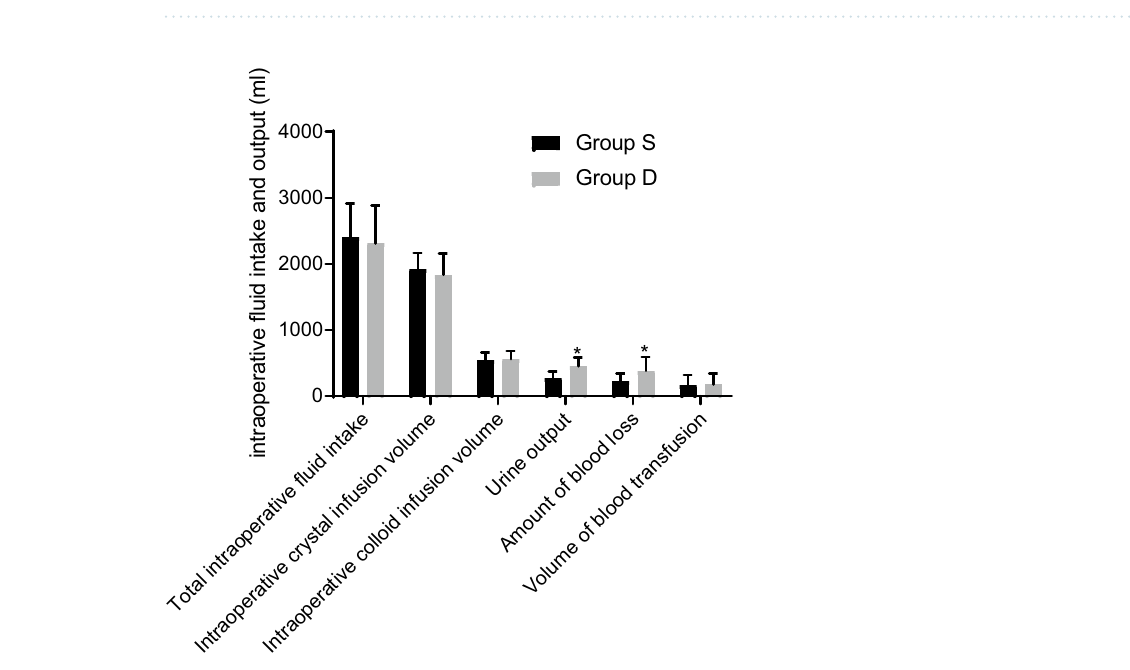
Table 3. Comparison of intraoperative fluid intake and output between the two groups of patients ( x ± s). Compared with the group S, a P < 0.05.